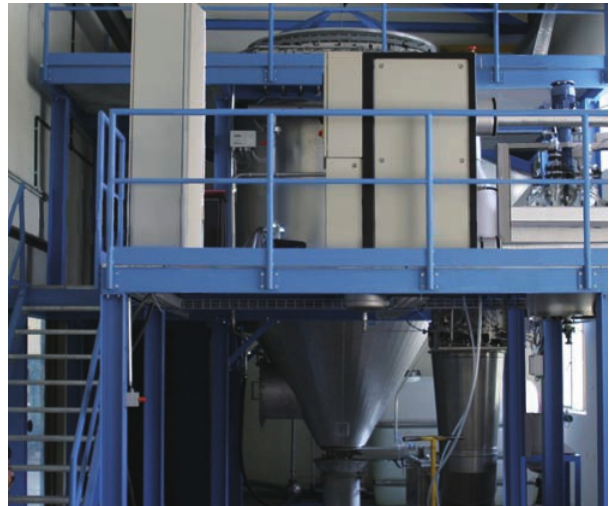
Fig. 6 Front view of the FSP pilot plant during installation at ARCI (Hyderabad, India) for production of several kg/h of nanoparticles with the baghouse filter for nanoparticle collection ( 〜 50 m 2 filtration area) at the back in the center, the stirred tank for precursor preparation on the right and the control cabinet for process automation on the left side of the